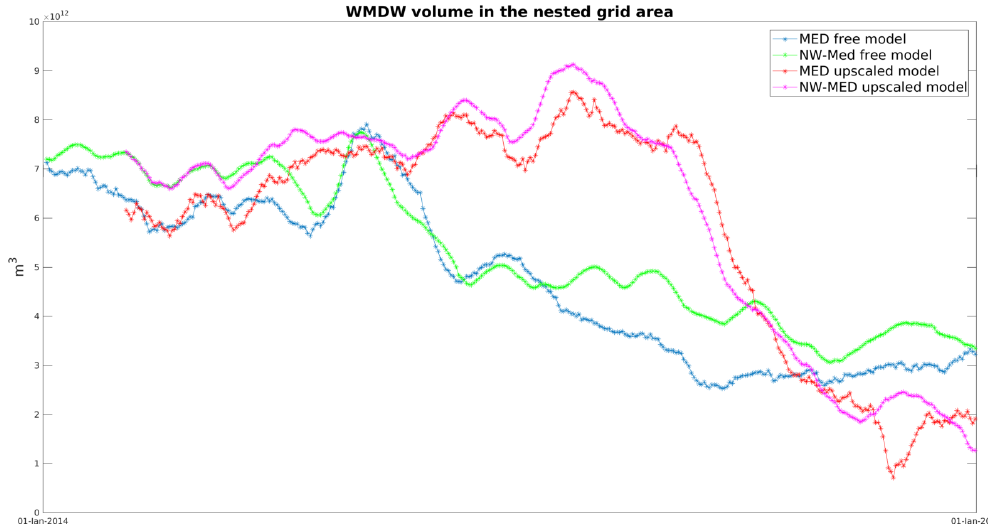
Figure 11. Time series of total amount of WMDW in the area covered by the nested model: (blue) free parent model, (green) nested model in the free model, (red) parent model with upscaling and (magenta) nested model in the upscaled model.